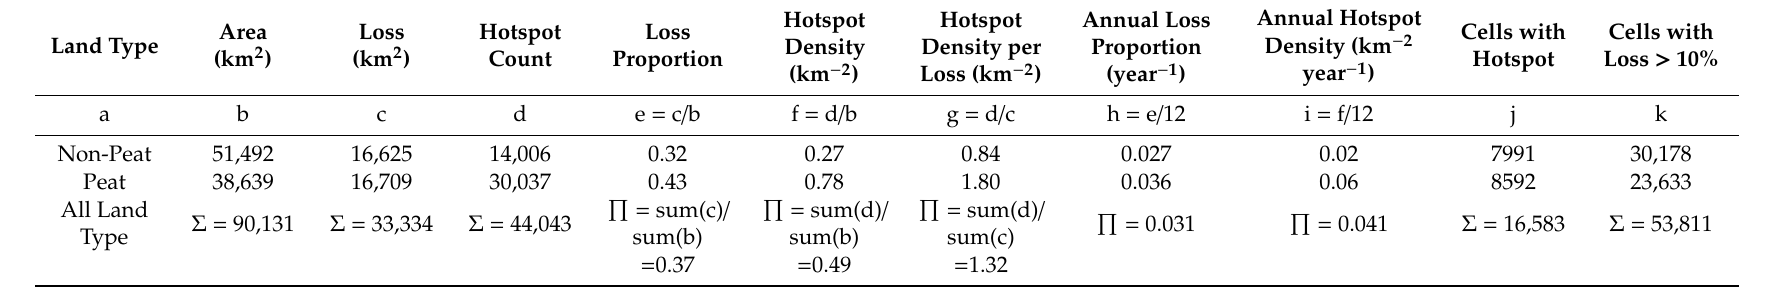
Table 1. Annual forest loss and hotspot density in peat and non-peatland